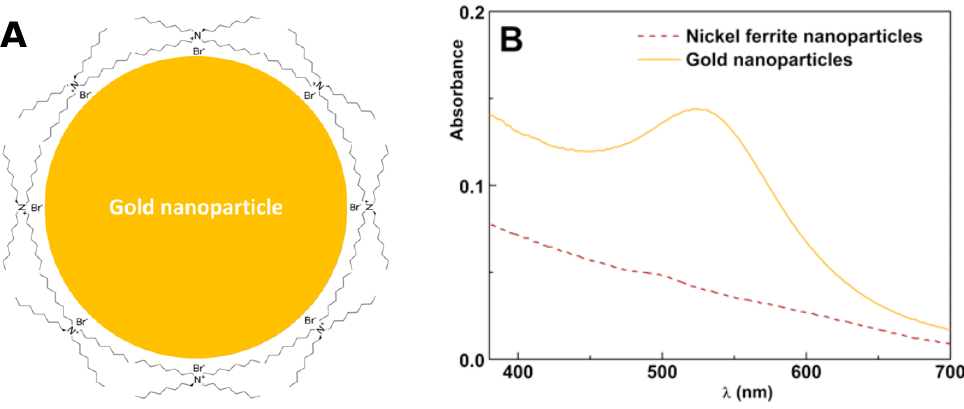
Figure 2. ( A ) Schematic representation of the interactions between R 4 N + and Br − species adsorbed on the gold nanoparticle surface. ( B ) Absorption spectra of nickel ferrite nanoparticle and gold nanoparticle dispersions.